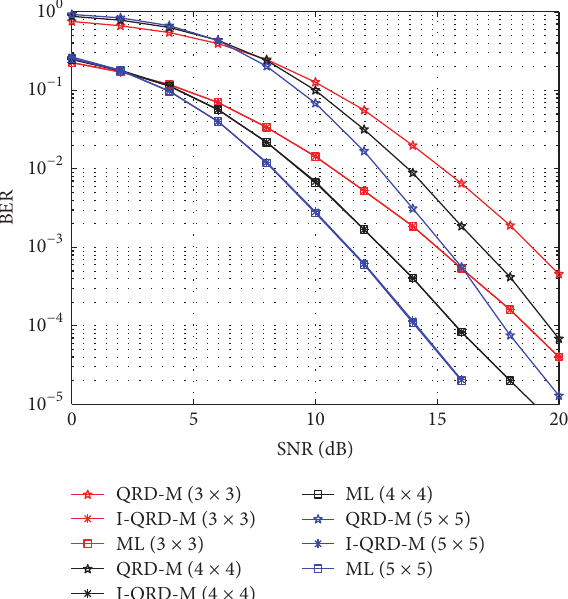
Figure5:BERcomparisonforGSMschemeversusSNRfordifferent antenna configurations with 𝑁 𝐴 = 3 and 𝑀 = 5 for 4-QAM.